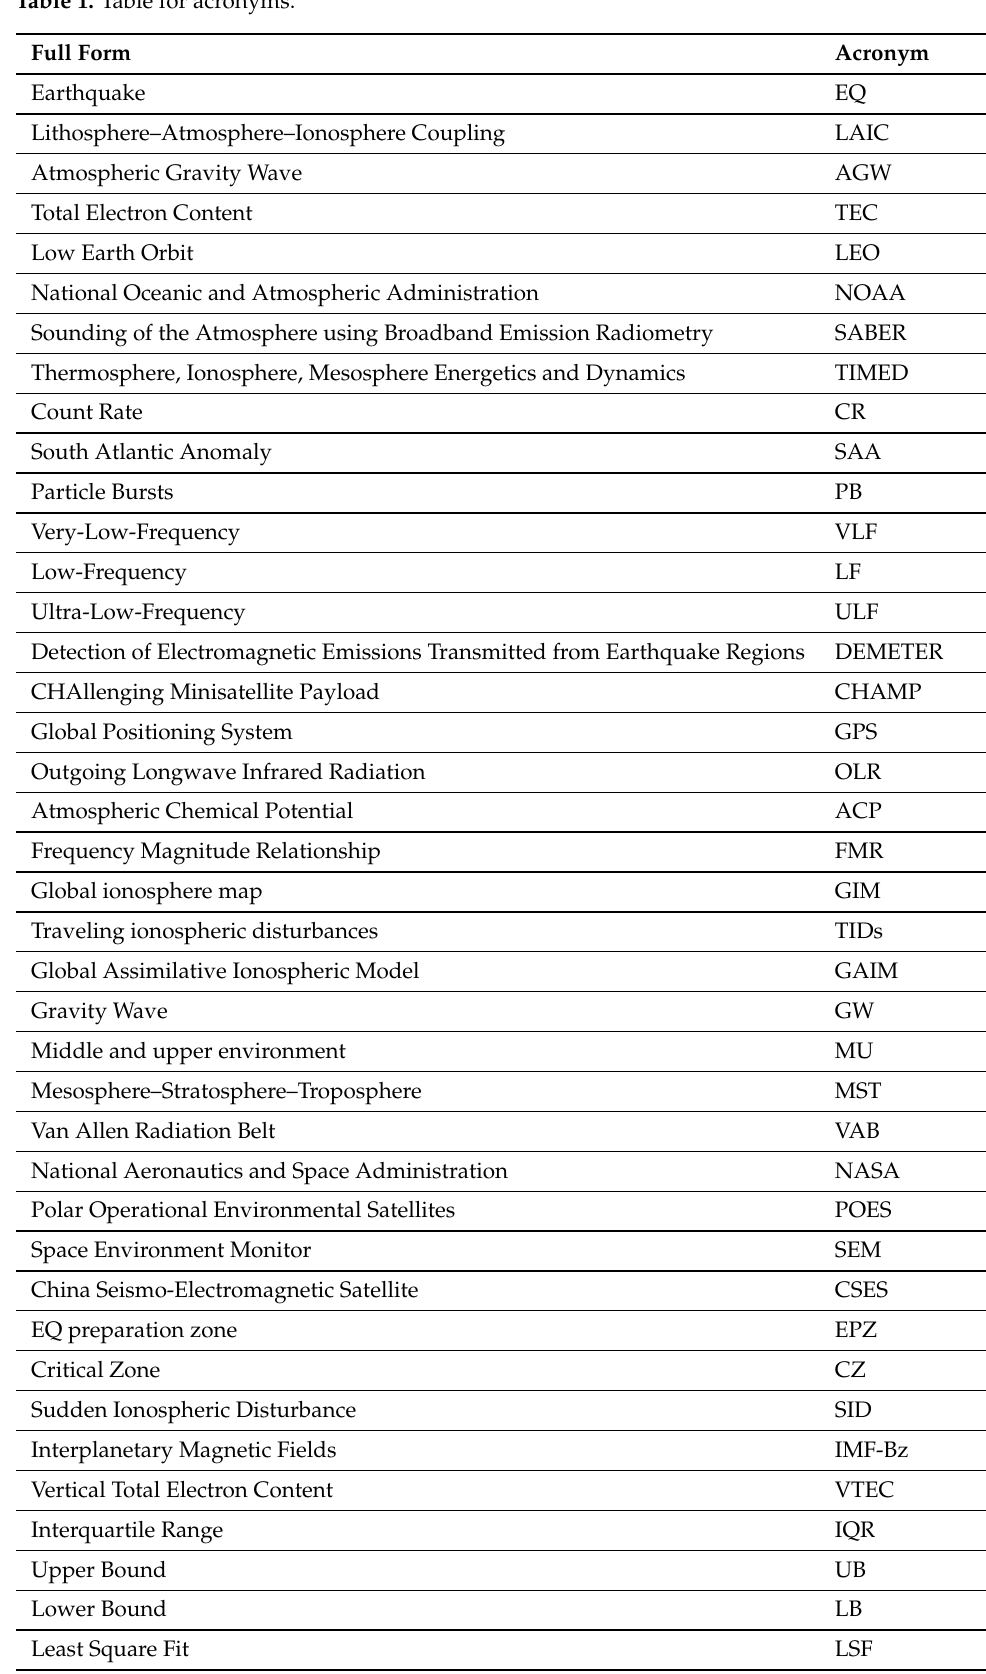
Table 1. Table for